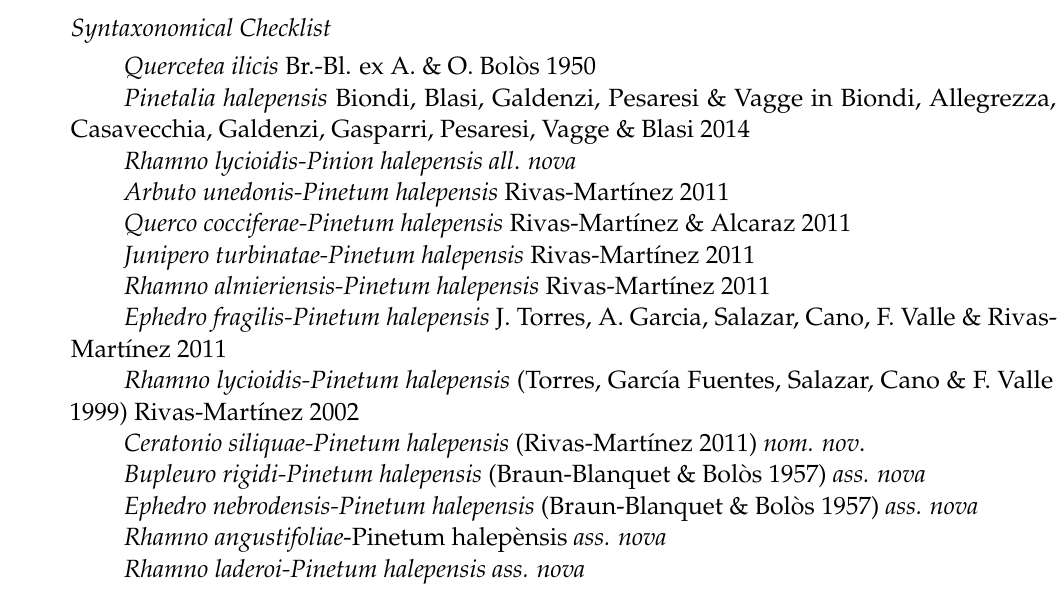
Table S2: Bupleuro rigidi-Pinetum halepensis ; Table S3: Rhamno angustifoliae-Pinetum halepensis ; Table S4: Rhamno laderoi-Pinetum